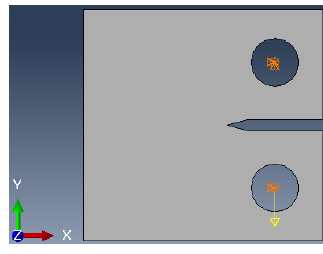
Figure 6. Boundary conditions and loads in the models.